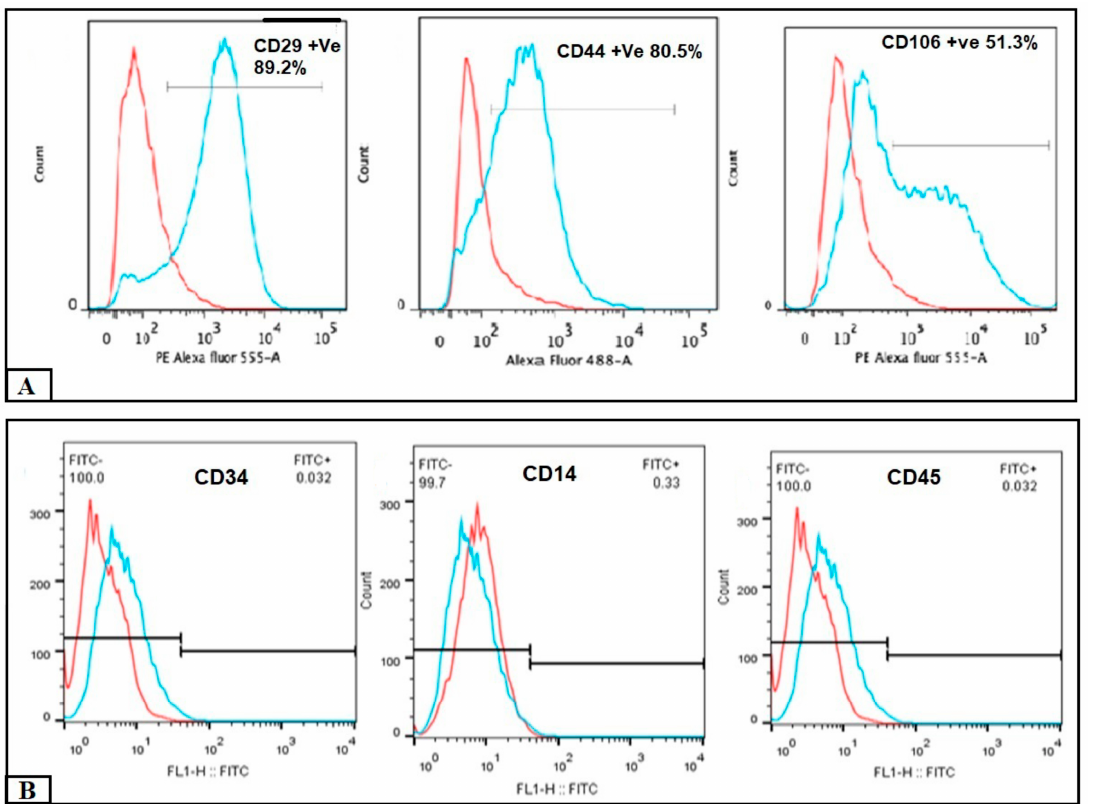
Figure 1. BM-MSCs characterization. Flow cytometry histograms for BM-MSCs showing positivity for CD29, CD44 and CD106 ( A ) and negativity for CD34, CD14 and CD45 ( B